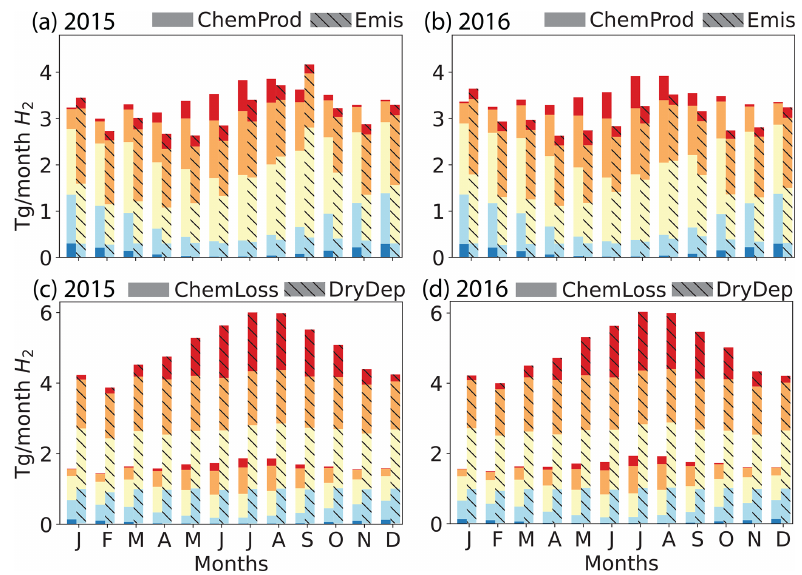
Figure 3. Simulated global monthly H 2 sources ( a, b , chemical production (solid) and emissions (hashed)) and sinks ( c, d , chemical losses (solid) and dry deposition(hashed)) for 2015 (left: a, c ) and 2016 (right: b, d ), calculated using the GEOS-Chem baseline simulation. Both sources and sinks are aggregated by latitudinal band as follows: red – high Northern Hemisphere (HNH) north of 45 ◦ N; orange – lower Northern Hemisphere (LNH) from 15 to 45 ◦ N; yellow – tropics (TP) from 15 ◦ S to 15 ◦ N; light blue – lower Southern Hemisphere (LSH) from 15 to 45 ◦ S; dark blue – high Southern Hemisphere. The emissions (Emis) include anthropogenic, biomass burning and biogenic N 2 fixation sources. The chemical production (ChemProd) includes photochemical formation from formaldehyde and glyoxal. The chemical loss (ChemLoss) considers the reaction with OH. The dry deposition (DryDep) is also